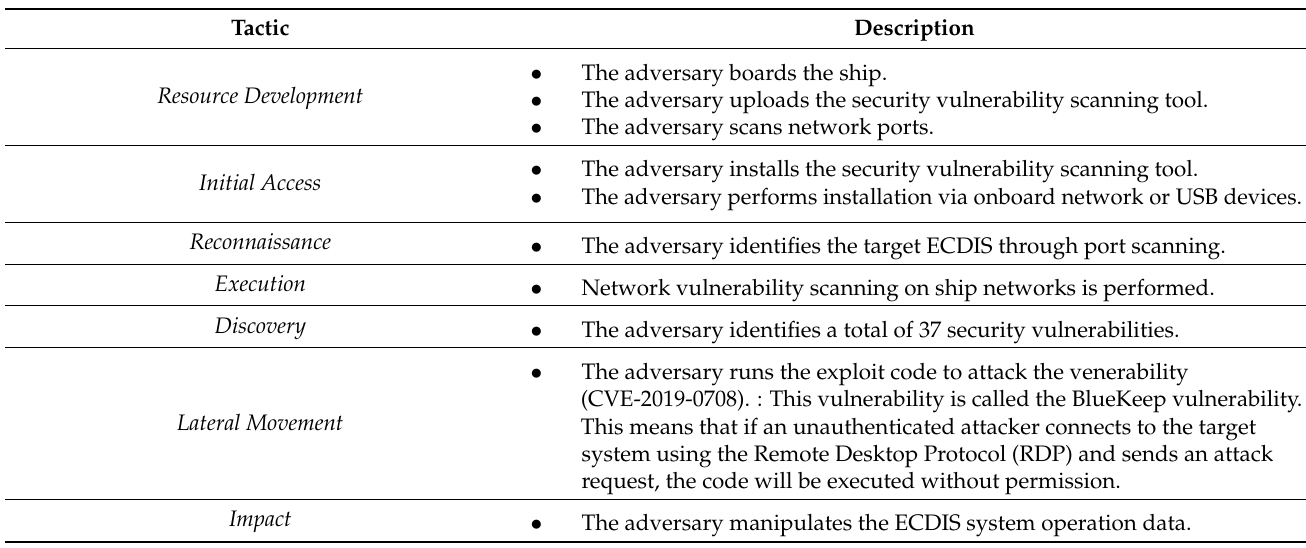
Table 5. MITRE ATT&CK analysis results attack case